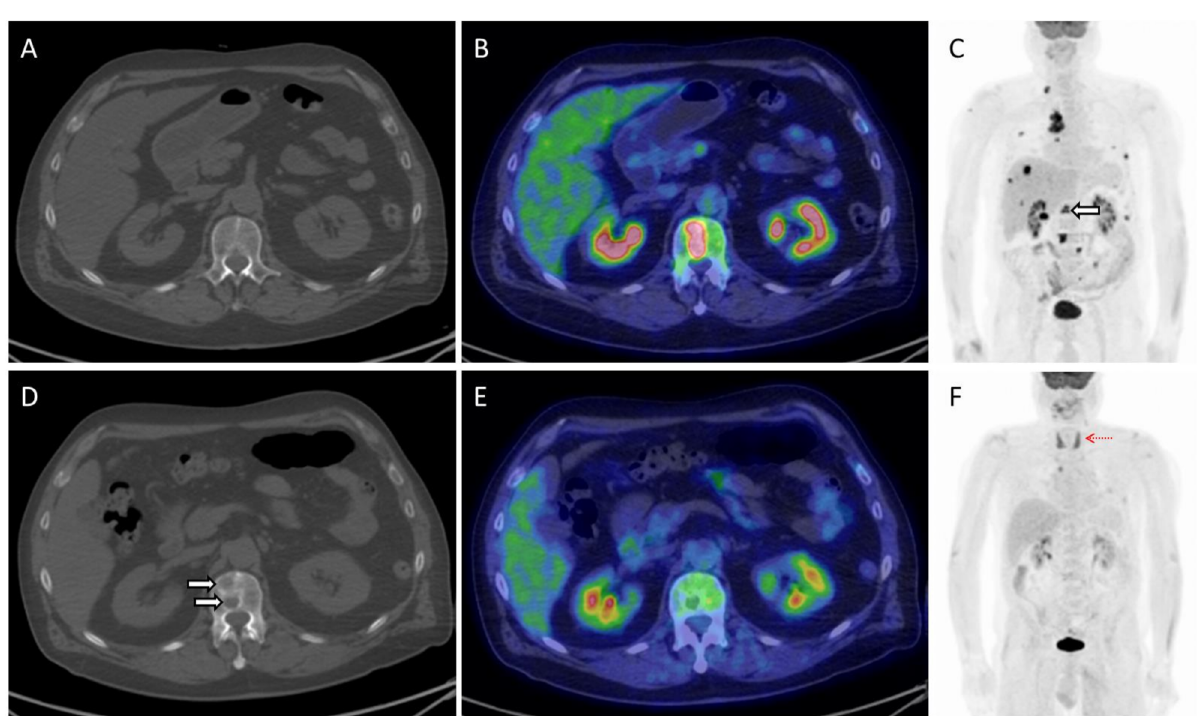
Figure 3. Herein, the imaging findings of a 66-year old male with metastatic NSCLC investigated before ( A – C ) and after 3 cycles of pembrolizumab ( D – F ). An overall response to treatment is easily visible on MIP (maximal intensity projection) images ( C , F ), including a complete metabolic remission of all bony lesions (( C ); white hollowed arrow). On the contrary, morphological imaging proved the appearance of a new bone lesion in the first lumbar vertebra (( A , D ); white arrows), which in fact corresponded to a healed metastasis on PET/CT ( B , E ). Note also the appearance of diffuse thyroid uptake (( F ); red arrow), consistent with thyroiditis, one of the irAEs that typically predicts treatment response and good patient’s